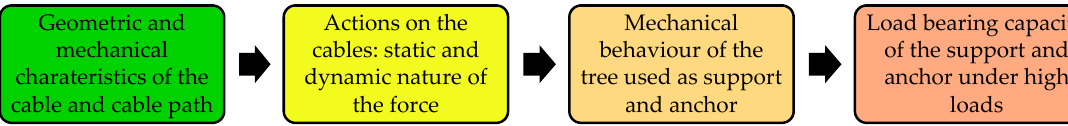
Figure 1. Schematic representation of the components that ought to be analyzed in order to assess the mechanical behavior of a cable-supported system. Colors try to highlight the different states of knowledge currently available by the designer from practice manuals and regulations for each respective component, (green = high; red = low).